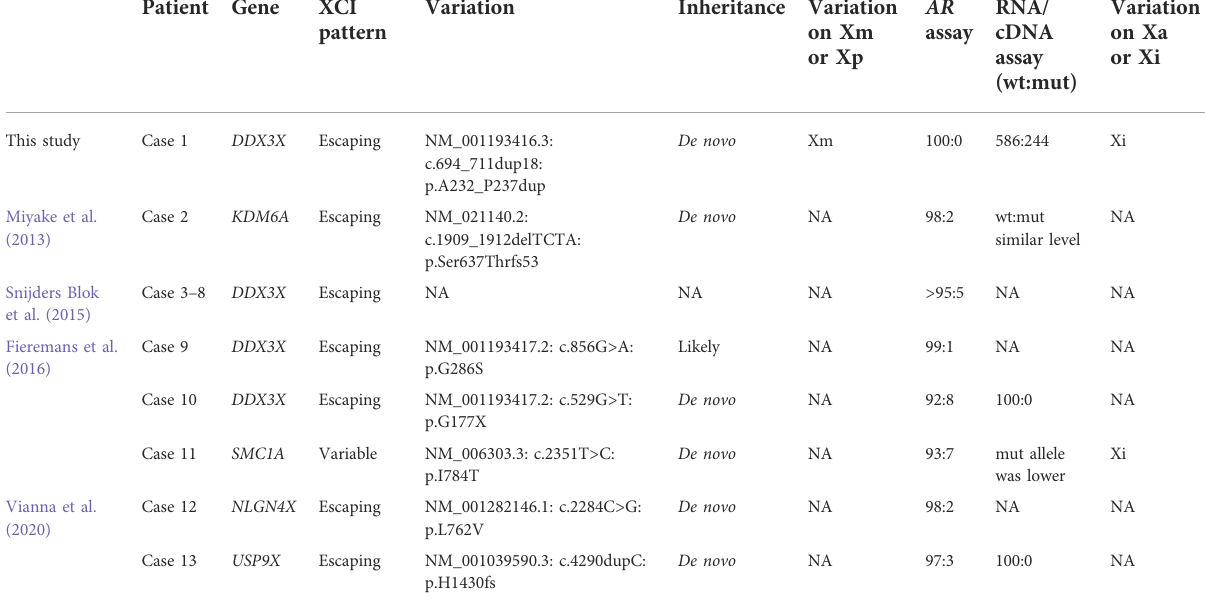
TABLE 1 Skewed XCI of female intellectual disability (ID) patients with variations in the escaping or variable XCI genes. Patient